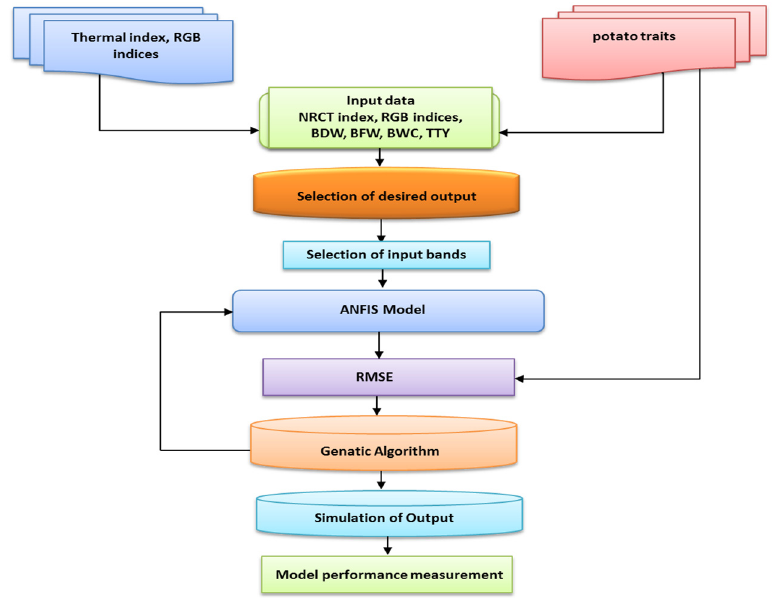
Figure 3. Schematic diagram of the methodology of adaptive neuro-fuzzy inference system (ANFIS) used in this study to predict the biomass fresh weight (BFW), biomass dry weight (BDW), biomass water content (BWC) and total tuber yield (TTY) of both potato varieties based on the selected thermal and RGB indices.